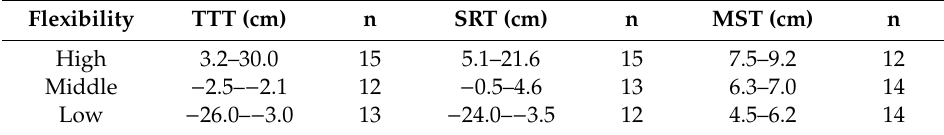
Table 2. Criteria for classifying the flexibility levels.